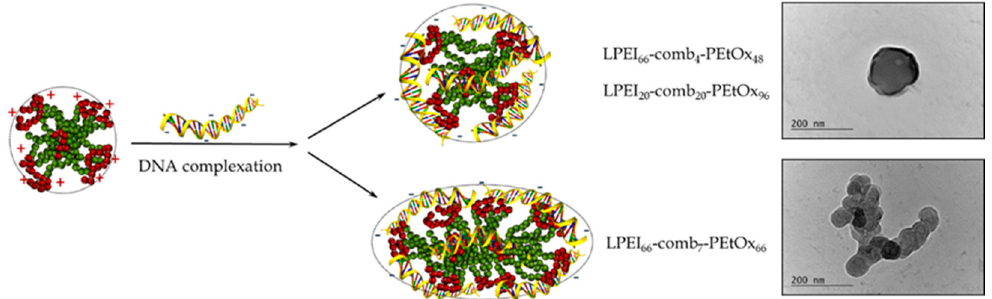
Figure 8. Schematic presentation of structure and morphology and TEM images of polyplex particles formed from PEtOx–PEI comb-like copolymers. Adapted from Haladjova et al. as published by the Wiley-VCH Verlag GmbH [40].